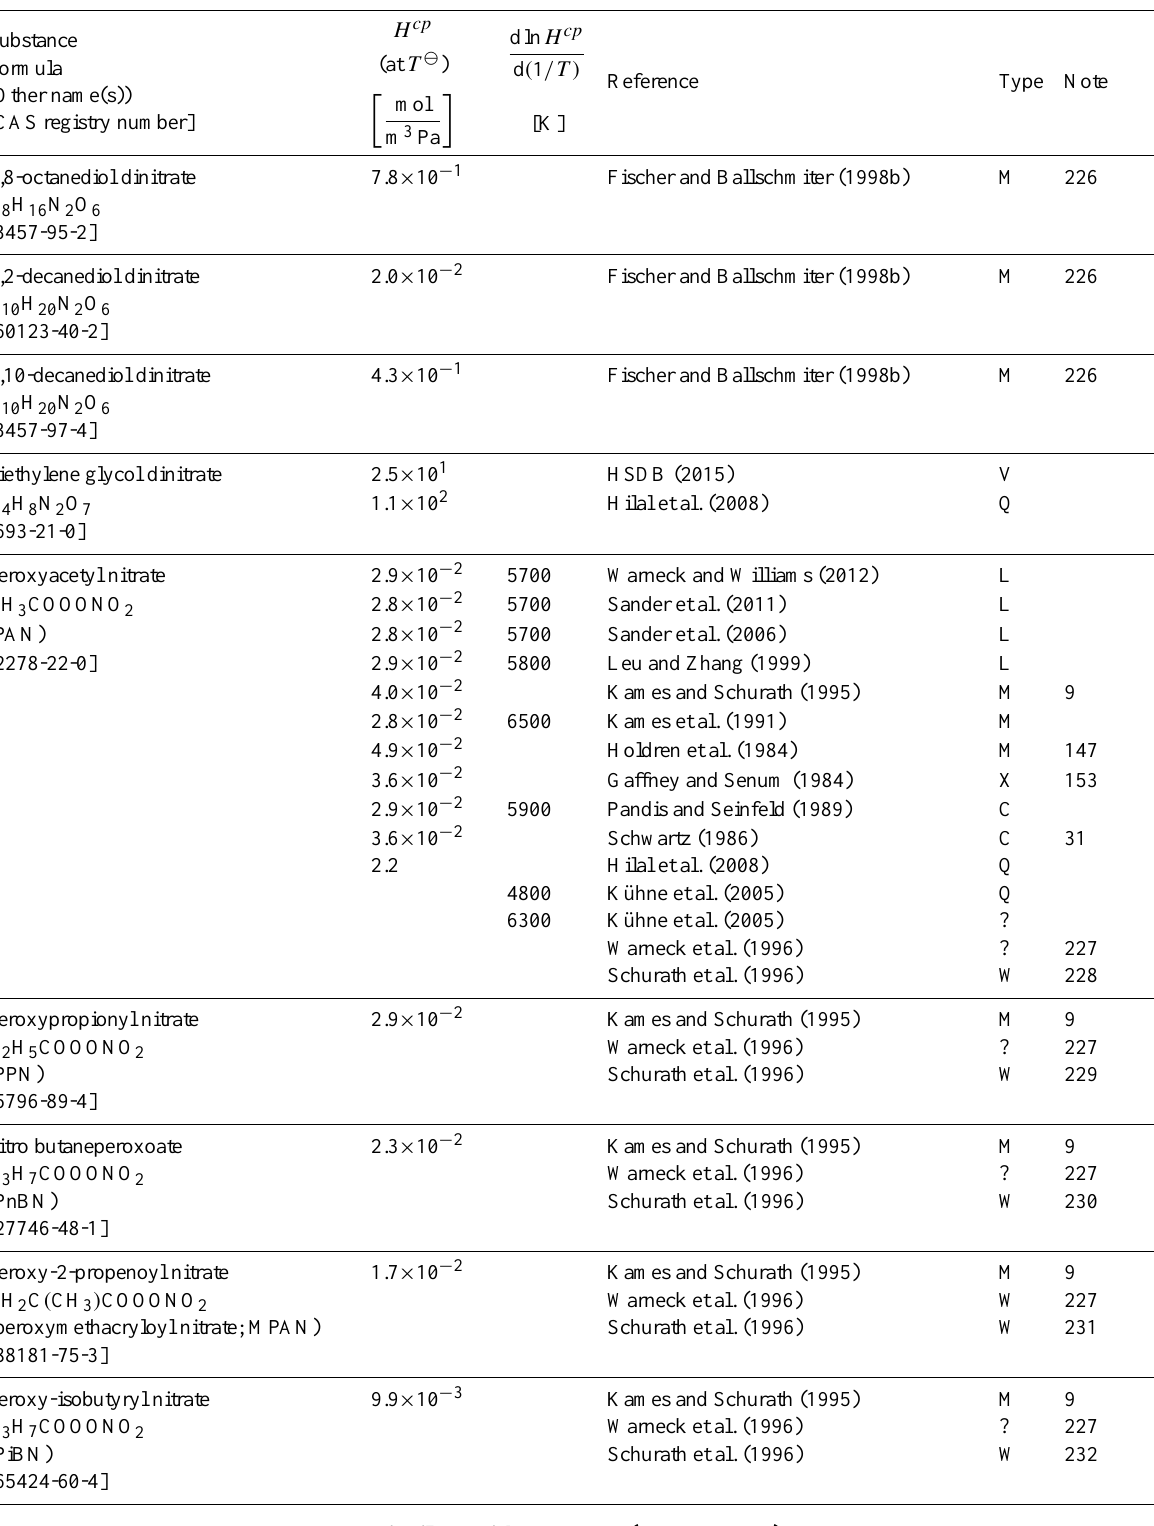
Table 6: Henry’s law constants for water as solvent